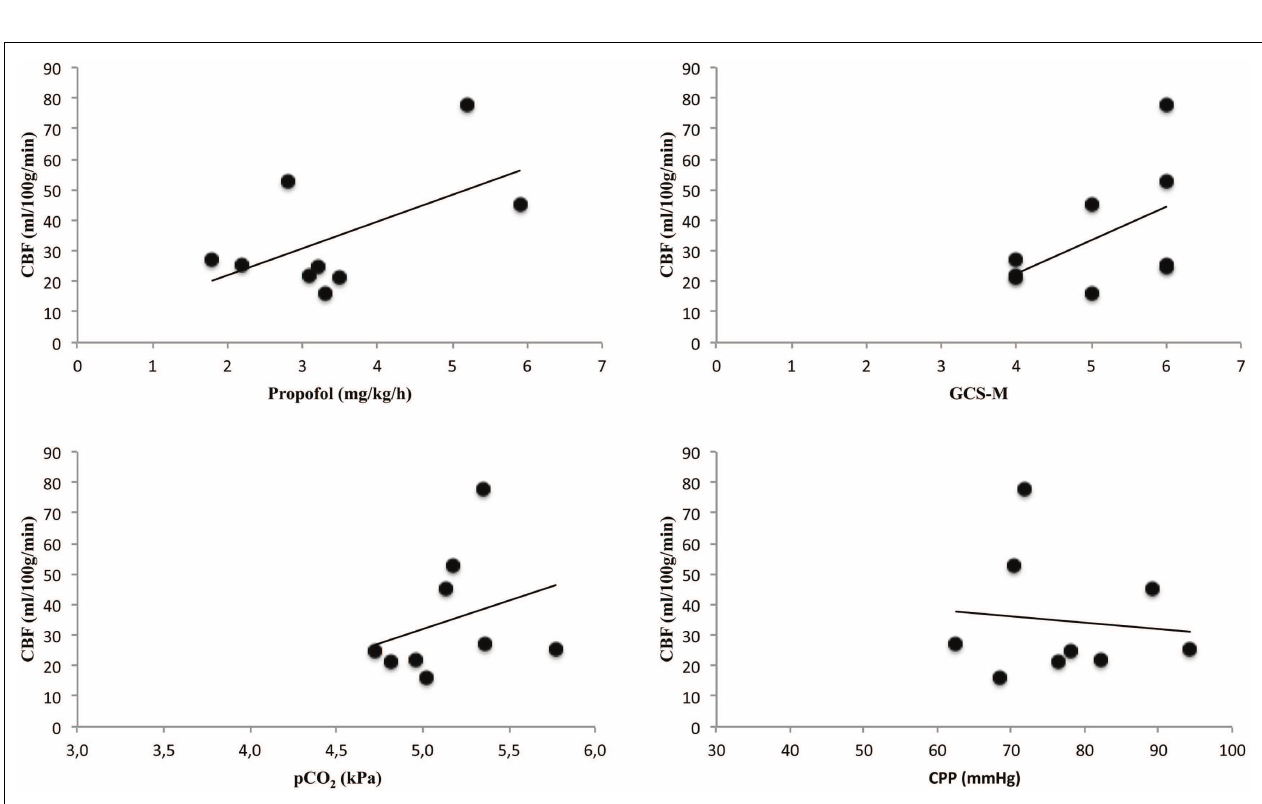
FIGURE 3 |The figure presents correlations between global cerebral blood flow (CBF) and the amount of sedation (Propofol), neurological grade (GCS-M, Glasgow coma scale motor score), pCO 2 , and cerebral perfusion pressure (CPP) during Xenon-CT measurements .